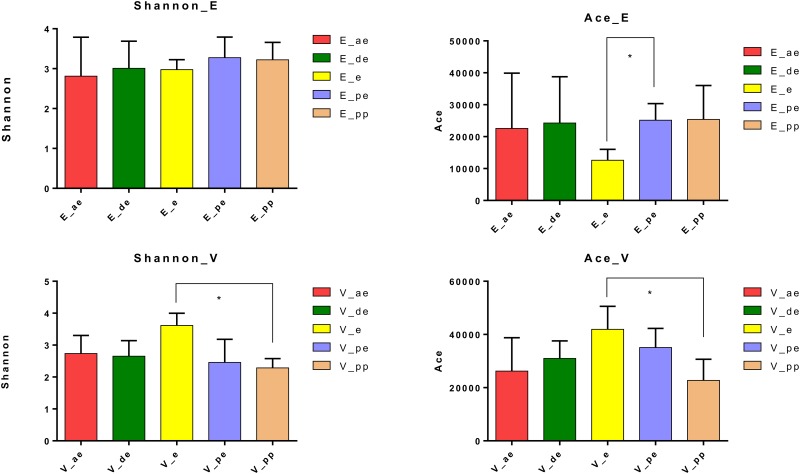
Variation in diversity (Shannon index) and richness (Ace) in endometrium (E) and vagina (V) at different stages of estrous cycle.Anestrus (ae) is depicted in red, diestrus (de) in green, estrus (e) in yellow, pro-estrus (pe) in purple, and pre-pubertal (pp) in dark beige.